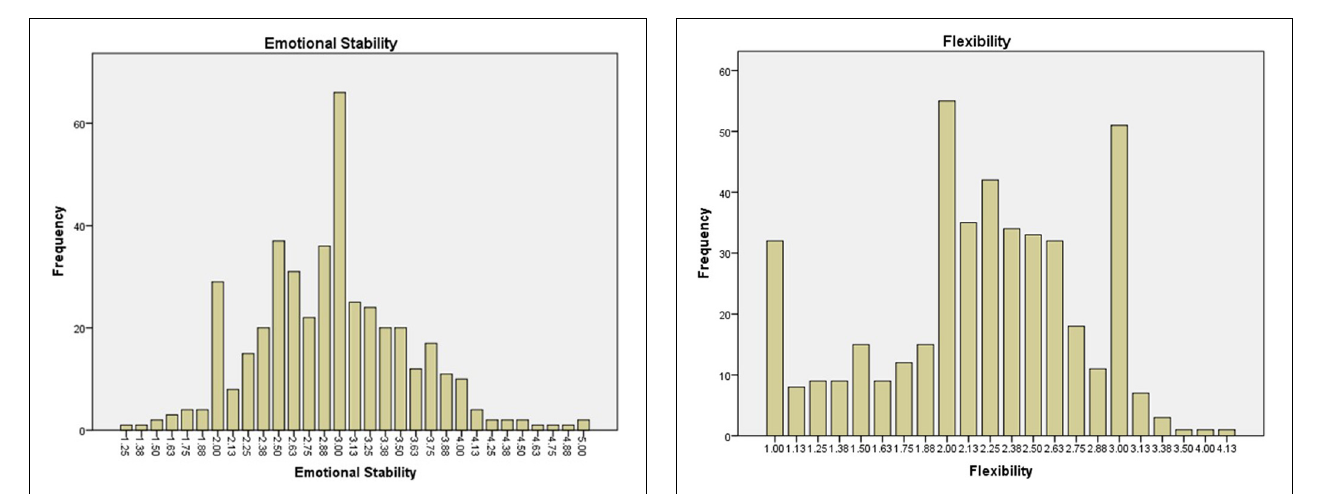
FIGURE 5 | Flexibility mean scores.